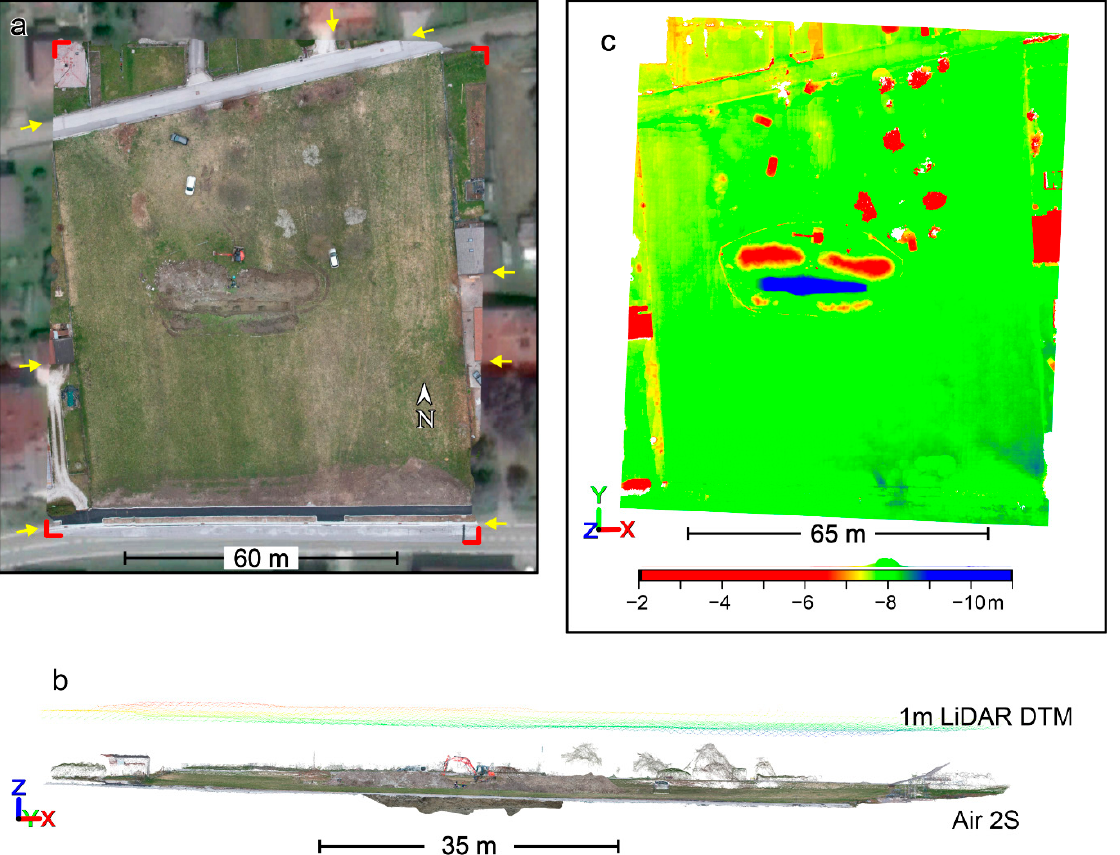
Figure 1. ( a ) Zenithal view of the kmz orthomosaic generated in Metashape from the Air 2S model. Note that no GCPs were used. Red corners highlight the limits of the orthomosaic overlay. Yellow arrows highlight matched features identified within the orthomosaic and Google Earth remotely sensed imagery. ( b ) Orthographic section view in CloudCompare of the Air2S model with the LiDAR ‐ derived Digital Terrain Model (DTM) at 1 m resolution of the region Friuli Venezia Giulia, and ( c ) zenithal view resultant cloud ‐ cloud computed distance.